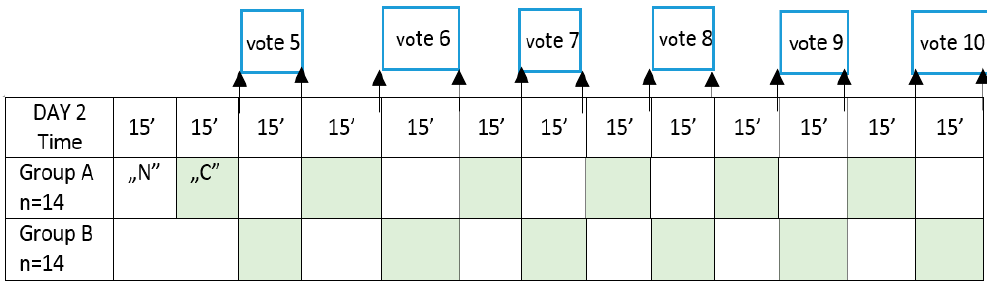
Figure 4. Experimental timetable (day 2, n = 28, “N”—neutral conditions, “C”—test chamber).